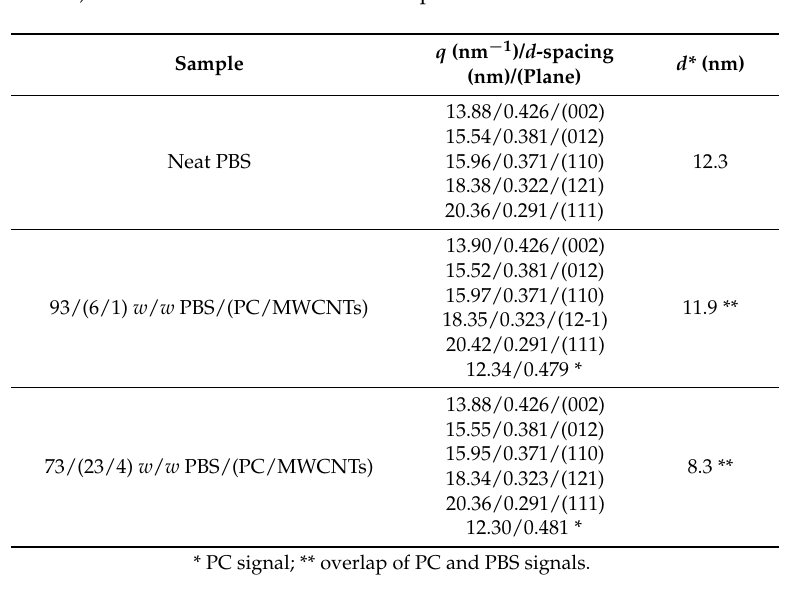
Table 2. Calculated values of d -spacing (from WAXS experiments) and long period ( d* , obtained from SAXS experiments) for the neat PBS and its nanocomposites.